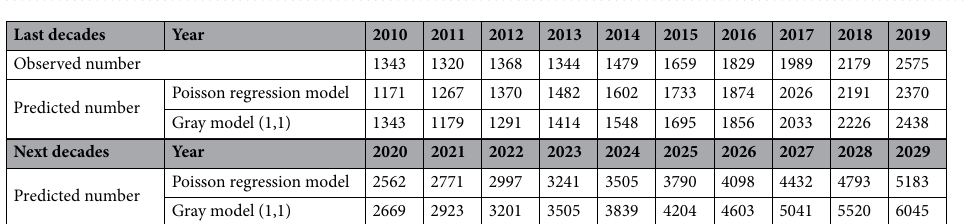
Table 3. Modelling predicted number of hypertrophic myocardiopathy over the next decades. For Gray model (1,1) analysis, the P value is 1 and the C value is 0.19.